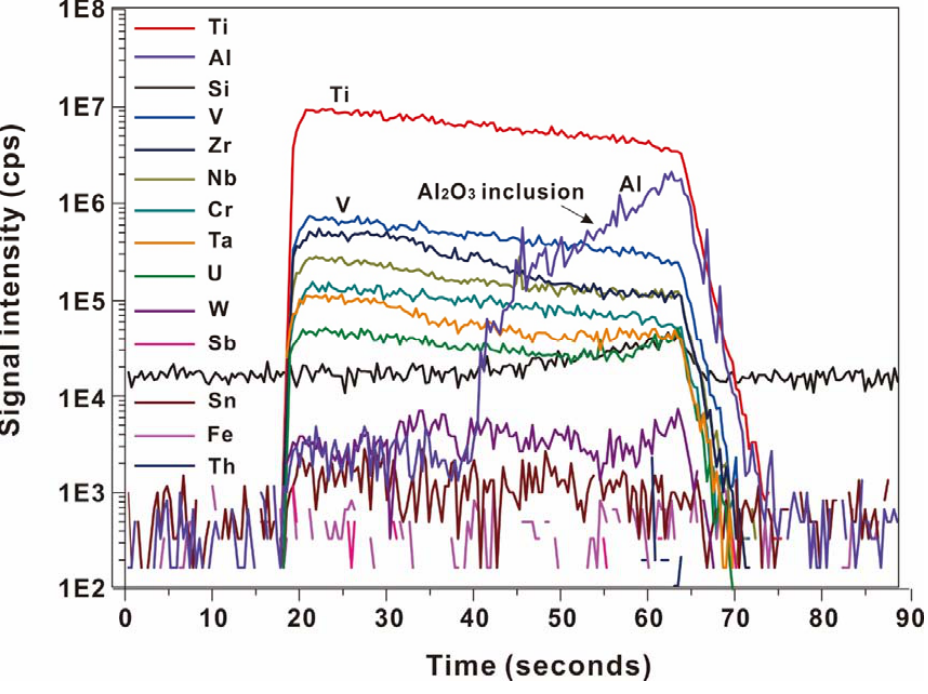
Figure 5. Time-resolved raw signal of rutile inclusion ablation signals (Ru-2).